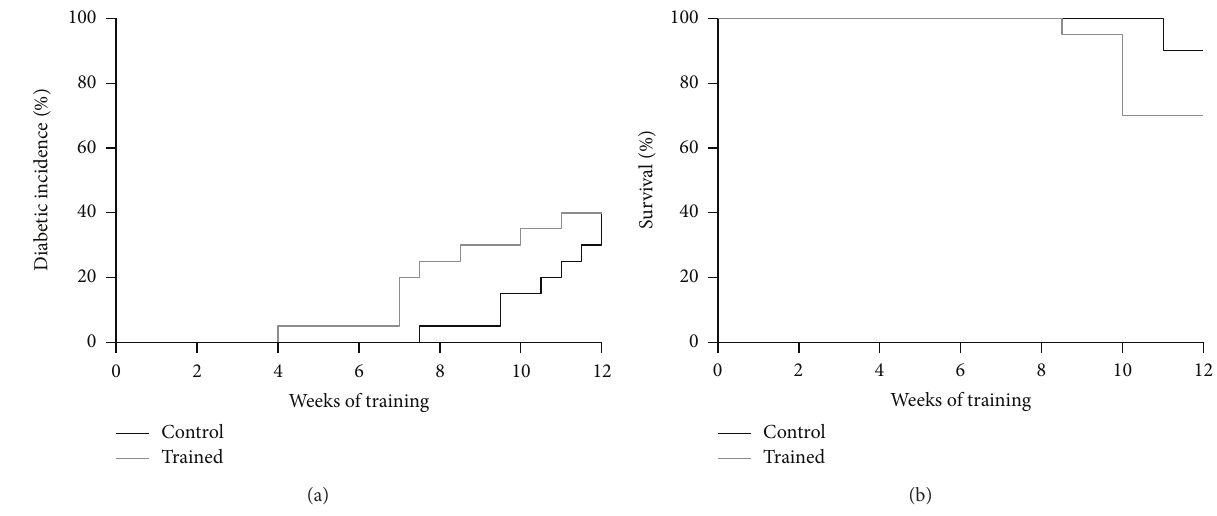
Figure 3: Incidence of type 1 diabetes (a) and survival (b) in all NOD mice.